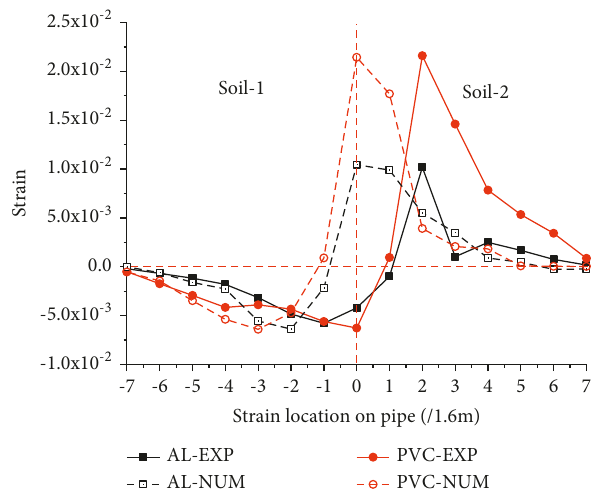
Figure 10: Initial strain of pipelines by uneven settlement of soils before seismic.